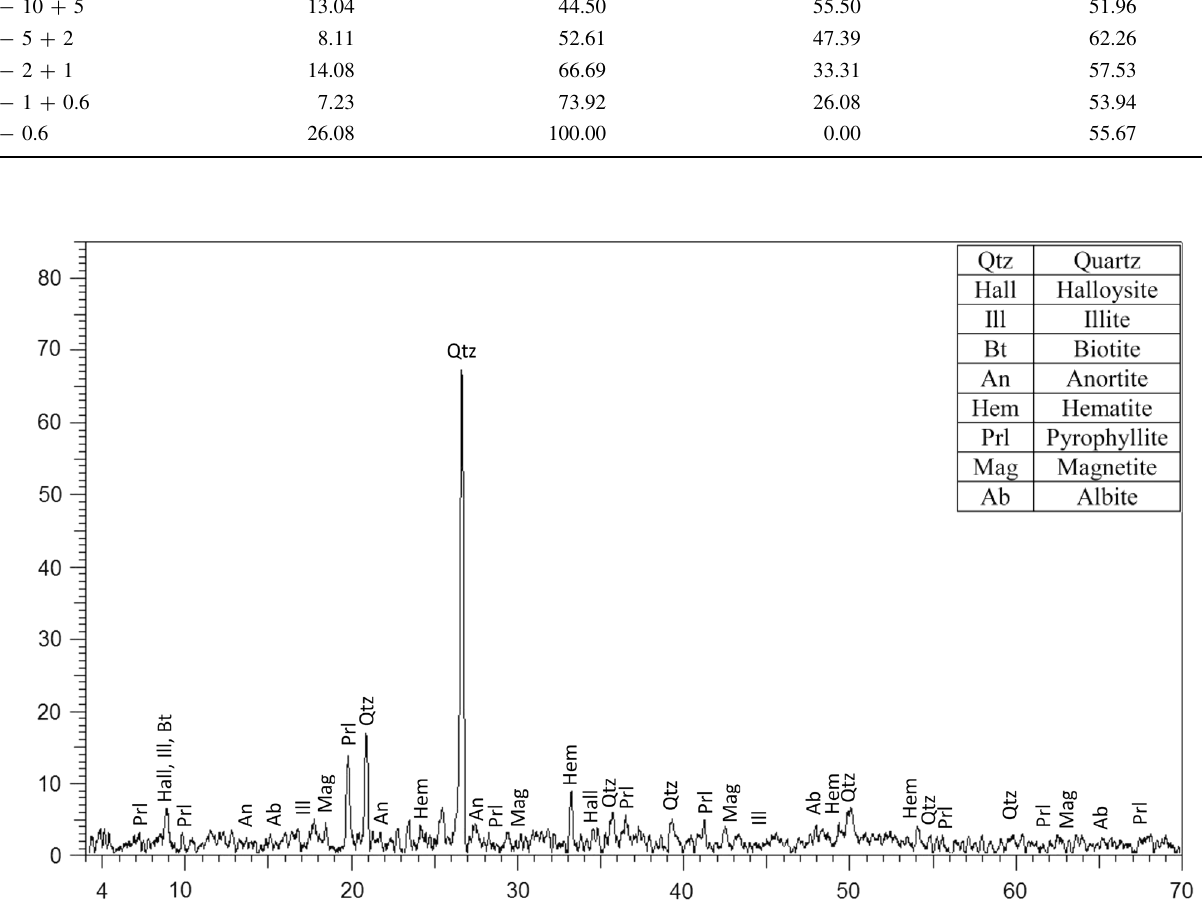
table test was performed under following conditions: shake amplitude 5 mm, shake frequency 180 cycle/min, longitu- dinal slope 3 degree and feed rate 200 g/min. Humphrey